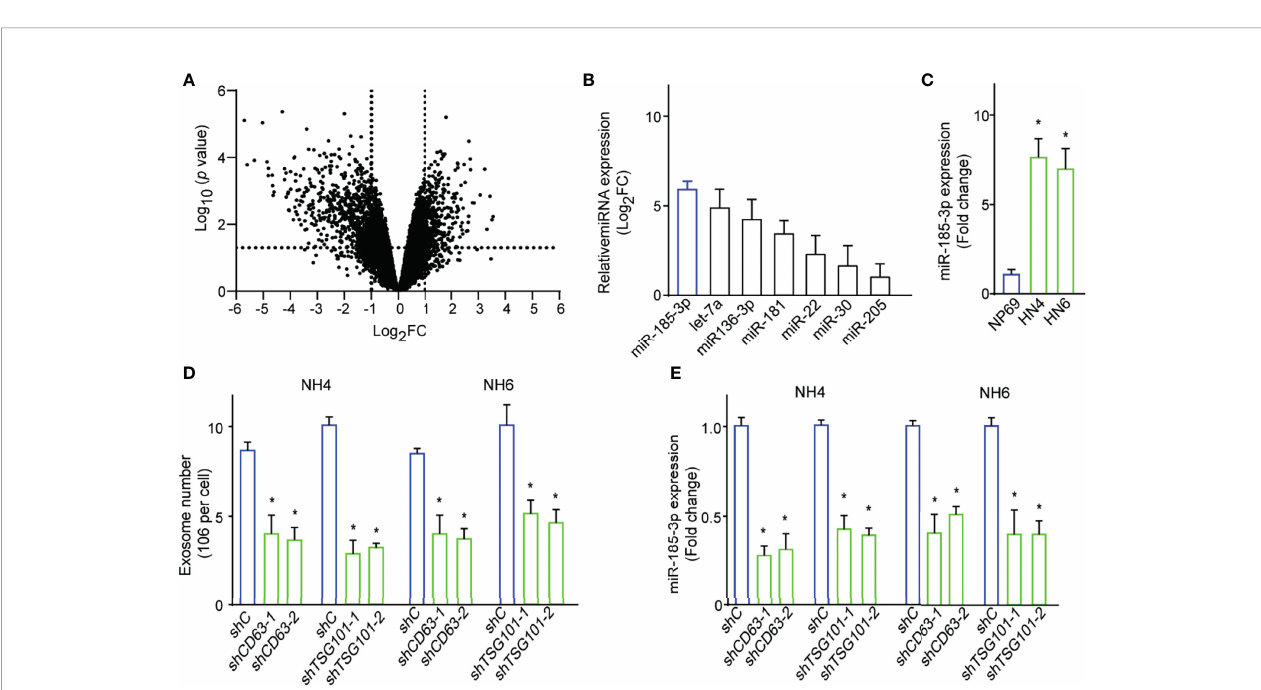
FIGURE 2 | A changed miRNAs expression pro fi le in HNSCC cells-derived exosomes. (A) Volcano plot shows the dysregulated miRNAs in tumor-derived exosomes compared with normal ones. (B) Expressions of the most dysregulated miRNAs in exosomes of HN4 cells con fi rmed by qRT-PCR. (C) The expressions of miR-185- 3p expression in HN4, HN6, and NP69. (D) Exosome numbers in cells with shCD63 or shTSG101 knockdown or control ones. (E) miR-185-3p expression in both HN4 and NH6 cells with shCD63 or shTSG101 knockdown or control ones. All experiments were replicated in triplicate. * p <